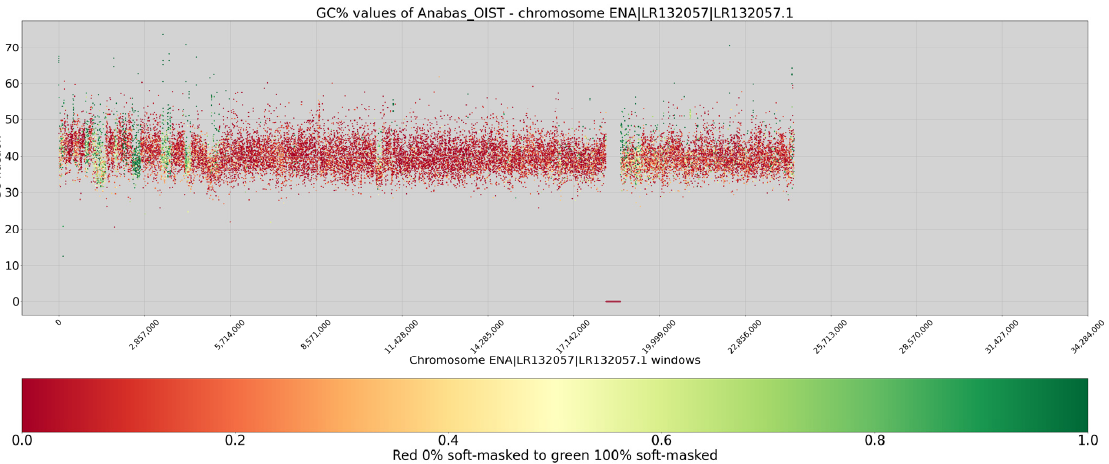
Figure 4. GC% profile of chromosome 21 in A. testudineus (or LR13257 in ENA), showing clear fluctuations in GC% between ~30–50%. x -axis, sequences in base pairs (bp); y -axis, GC%. Regions with green dots are accumulations of repetitive (i.e., soft-masked) sequences. The sliding window size is 1,000 bp.